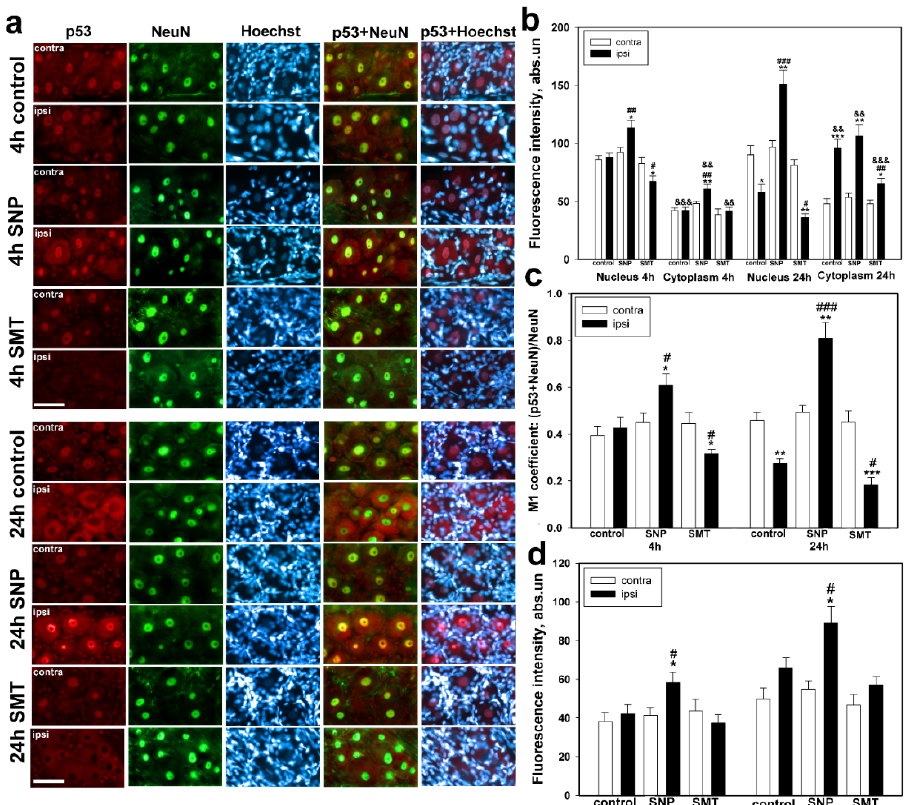
Figure 1. Immune-fluorescent microscopy. ( a ) Expression of p53 (red fluorescence) in DRG neurons of rats of the control group, which were treated with physiological solution, and the experimental group, which were treated with either the NO donor (SNP) or the iNOS selective inhibitor (SMT), 4 h and 24 h after sciatic-nerve transection. The scale section is 50 μm. ( b ) The dependence of mean p53 fluorescence intensity in the nuclei and cytoplasm of neurons of the contralateral and ipsilateral DRG of the control and experimental groups of animals 4 h and 24 h after sciatic-nerve transection. ( c ) The M1 coefficient of colocalization of p53 and the NeuN neuronal nuclei marker in the contralateral and ipsilateral DRGs of the control and experimental groups of animals 4 h and 24 h after sciatic-nerve transection. ( d ) The dependence of mean p53 fluorescence intensity in glial cell nuclei of DRGs 4 h and 24 h after sciatic-nerve transection. Ipsi—the axotomized ipsilateral ganglion; contra—the contralateral ganglion; NeuN—neuronal nuclei marker (green fluorescence); NeuN+p53 and Hoechst+p53—overlap; Hoechst—the fluorescence of Hoechst 33,342, which allows visualization of nuclei of both neurons and glial cells. One-way ANOVA. Mean ± SEM. n = 6. * p < 0.05, ** p < 0.01, *** p < 0.001—ipsilateral DRG with respect to the contralateral DRG of the same animal; # p < 0.05, ## p < 0.01, ### p < 0.001—ipsilateral DRG with respect to the ipsilateral DRG of the control group animal within the framework of the same time interval after axotomy; && p <